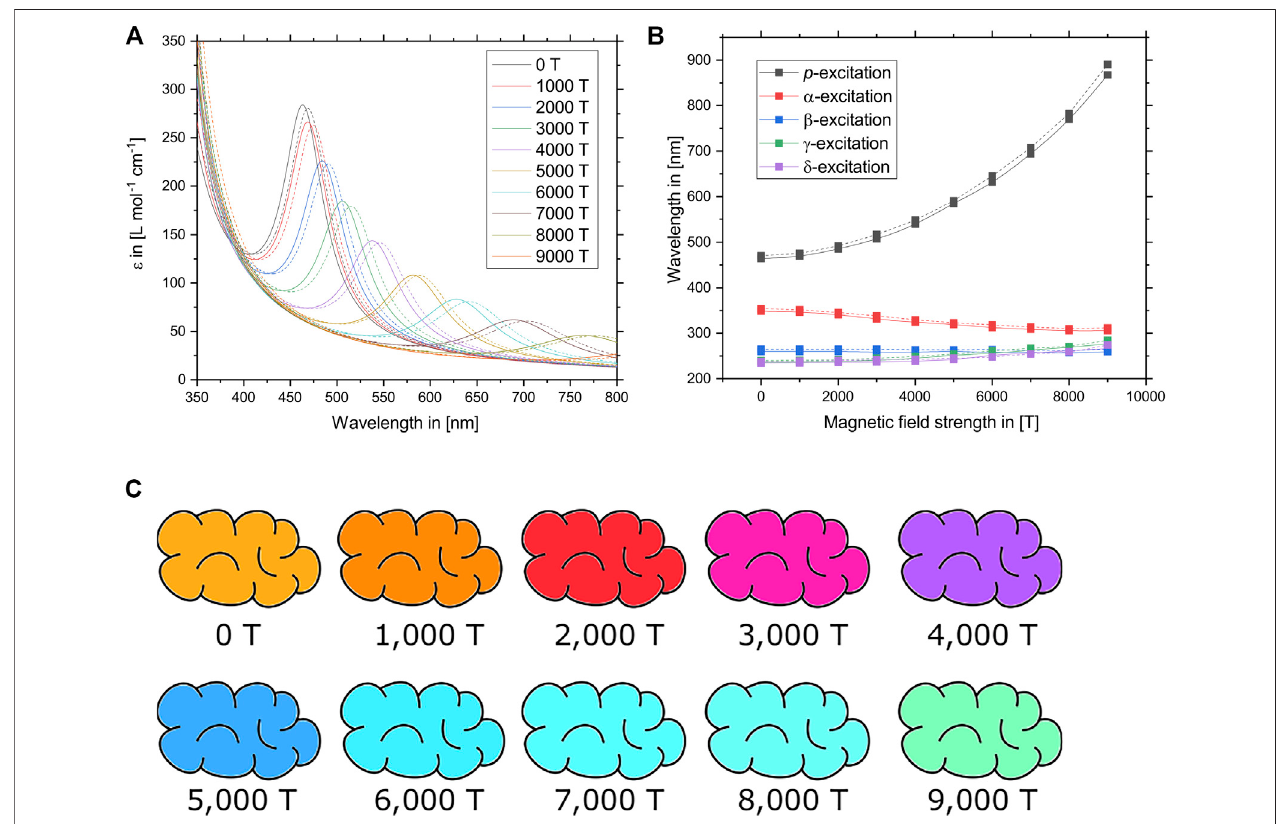
FIGURE4|(A) UV/Visspectraoftetraceneaspredictedatdifferentmagnetic fi eldstrengthsbetween0Tand9,000 T.SolidlinesdenotecalculationsusingtheCD- ev GW (10)/BSE@BHLYP method while dashed lines denote CD-ev GW (10)/BSE@CAM-B3LYP calculations. (B) Wavelengths of the relevant lowest vertical excitations of tetracene at different magnetic fi eld strengths between 0 T and 9,000 T. The p -excitation, which is predominantly responsible for the colour of tetracene, is most affectedbytheexternal fi eld.SolidlinesdenotecalculationsusingtheCD-ev GW (10)/BSE@BHLYPmethod whiledashed linesdenoteCD-ev GW (10)/BSE@CAM- B3LYP calculations. (C) Colour of tetracene as predicted at the CD-ev GW (10)/BSE@CAM-B3LYP level of theory at different magnetic fi eld strengths between 0 T and 9,000 T. To obtain the depicted colours, the vertical excitations of the optical spectrum were broadened by 0.15 eV and converted into a RGB colour code while the intensity was scaled relative to the zero- fi eld by integrating over the visible region of the